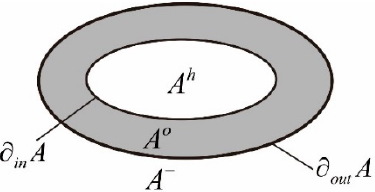
Figure A1. A’s five topologically distinct and mutually exclusive parts.